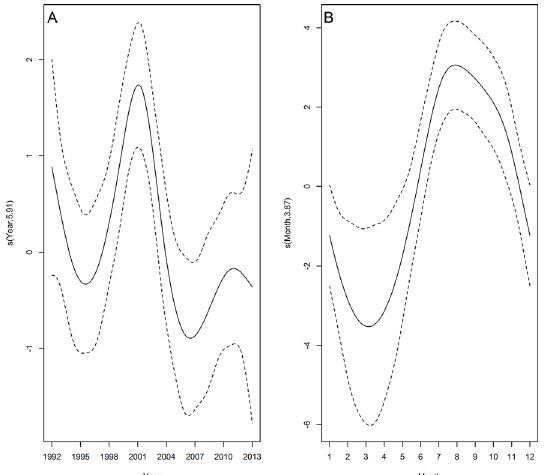
Fig 9. Temporal trends in subantarctic fur seal strandings. Estimated smooth function (solid line) with 95% confidence interval (dashed lines) for the fitted GAM by year (A) and month (B) from 1992 to 2013. Y- axis = fitted function with estimated degrees of freedom in